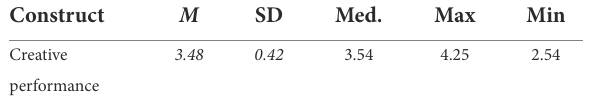
TABLE 3 Reliability and validity analysis. TABLE 4 Creative performance